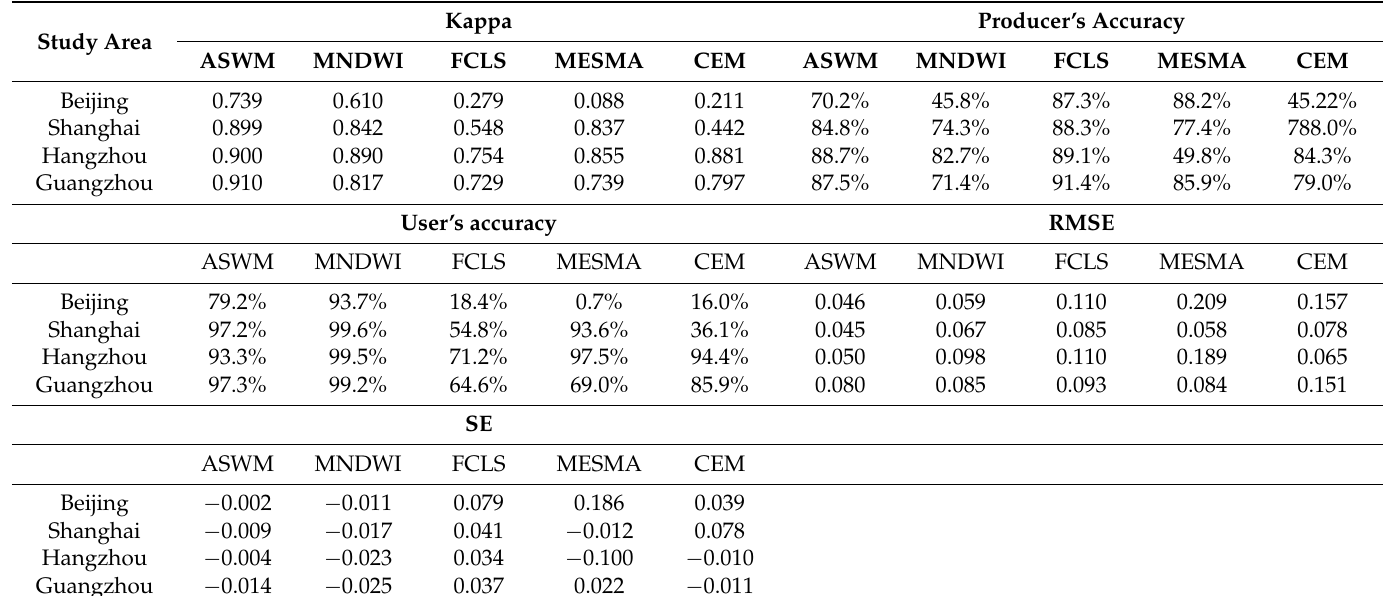
Table 2. Summary of the classification accuracy of the four classifiers by study